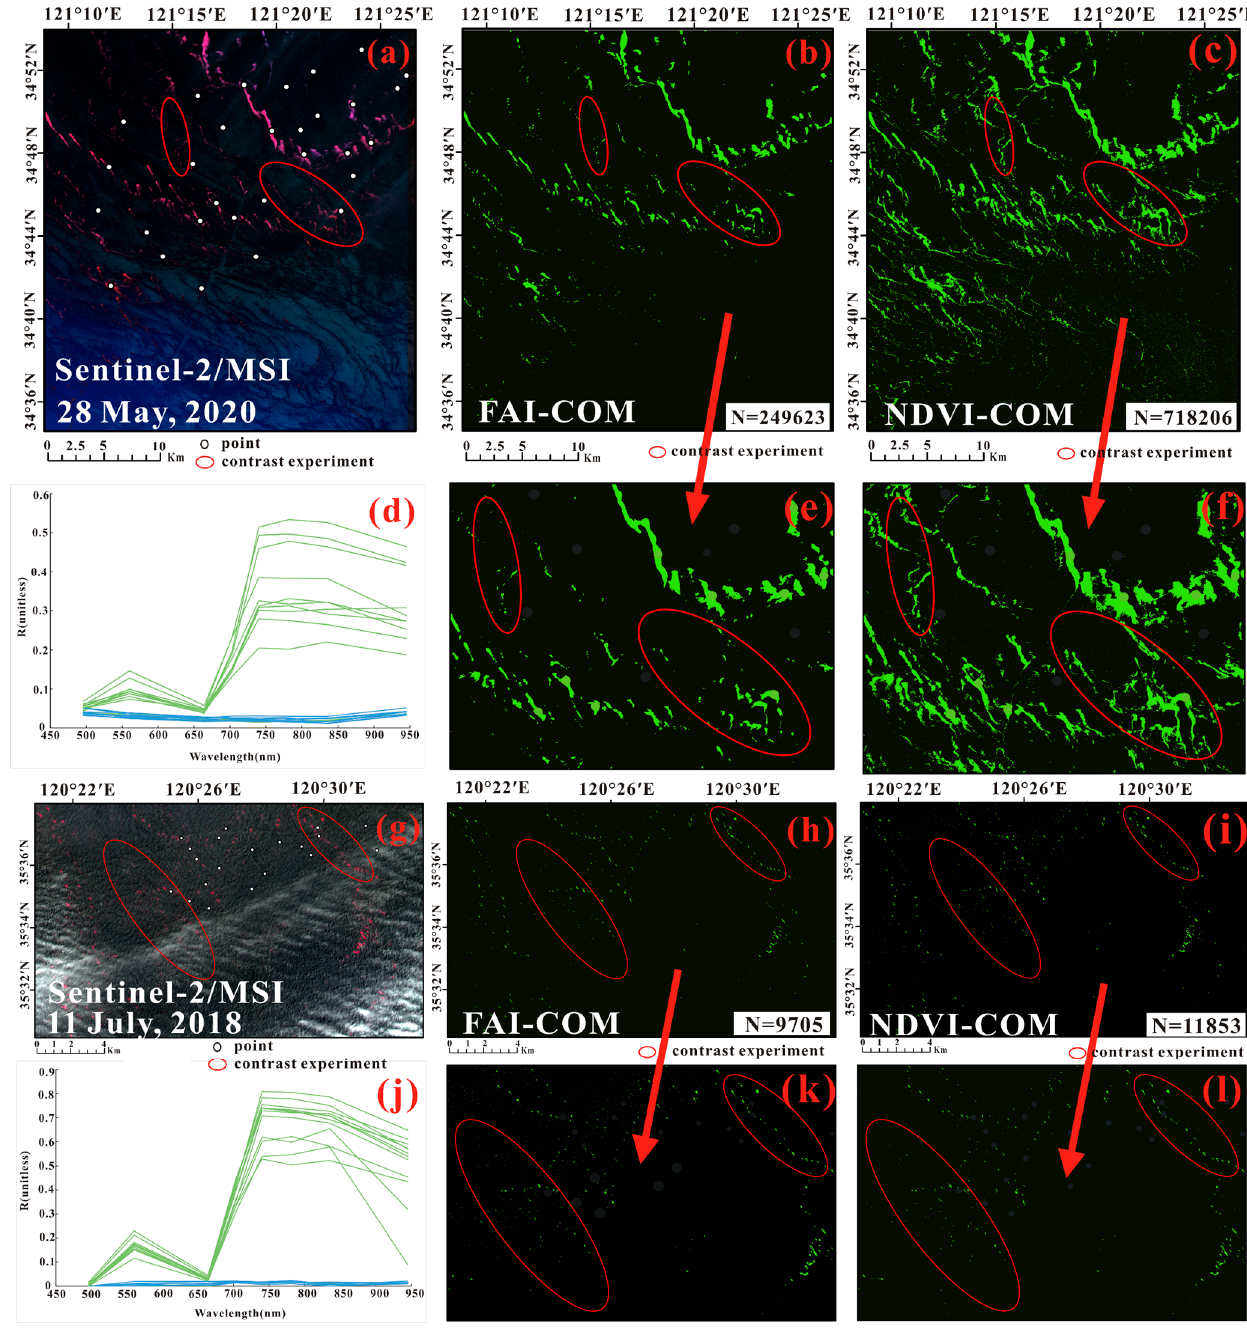
Figure 6. Comparison of U. prolifera extraction from Sentinel-2/MSI images on 28 May 2020 ( a – f ) and 11 July 2018 ( g – l ). “N” means the number of U. prolifera pixels. ( a , g ) Sentinel-2/MSI pseudo-true-color image, R:G:B = band 8:4:3, ( b , h ) U. prolifera extracted from FAI-COM, ( c , i ) U. prolifera extracted from NDVI-COM, ( d ) reflectance spectra with random points of U. prolifera and seawater corresponding to the eight Sentinel-2 bands on 28 May 2020, ( e , f ) enlarged view of ( b , c ), respectively, ( j ) reflectance spectra with random points of U. prolifera and seawater corresponding to the eight Sentinel-2 bands on 11 July 2018, ( k , l ) enlarged view of ( h , i ), respectively.